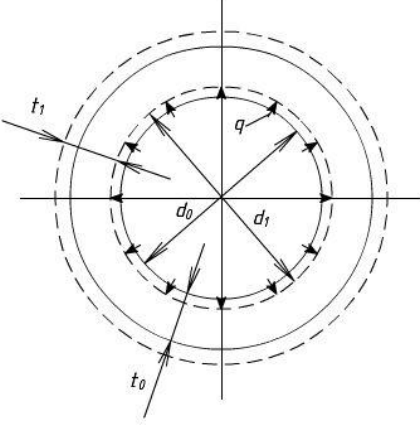
Fig. 9. The calculated expansion